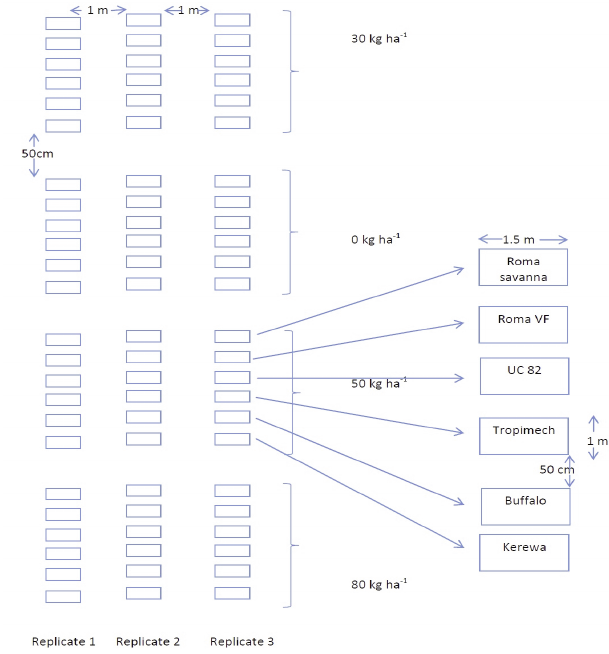
Fig. 1 ­ Plot layout of the field showing the arrangement of plots within the field. Plots in group of six represent the culti­ vars arranged randomly within each